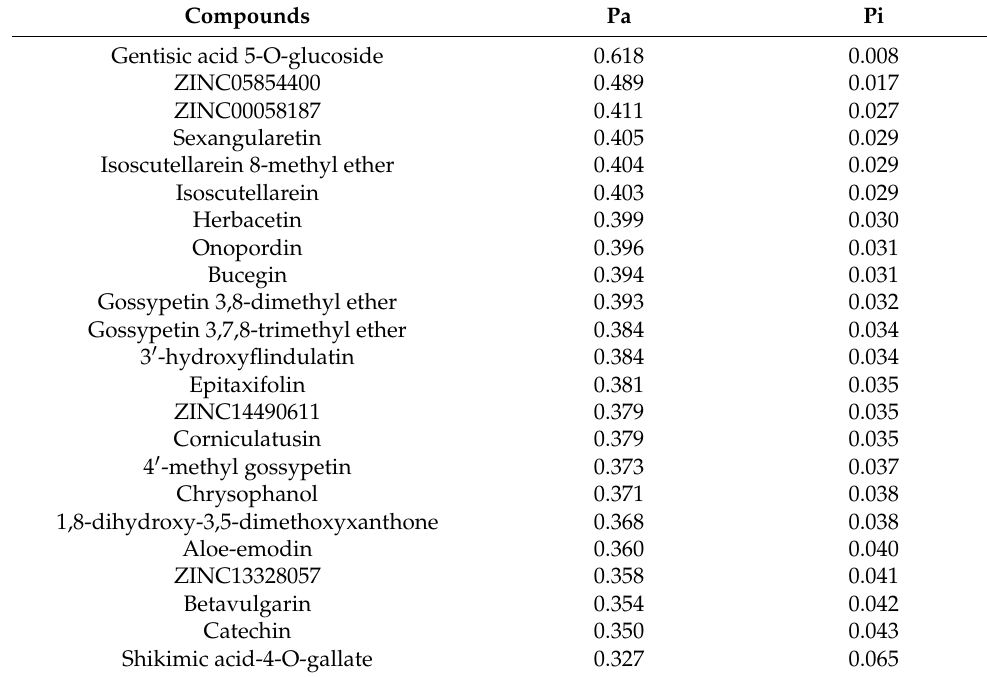
Table 4. Compounds with their Pa and Pi values for predicted antibacterial activity. When Pa > Pi, the compound is worth being pharmacologically